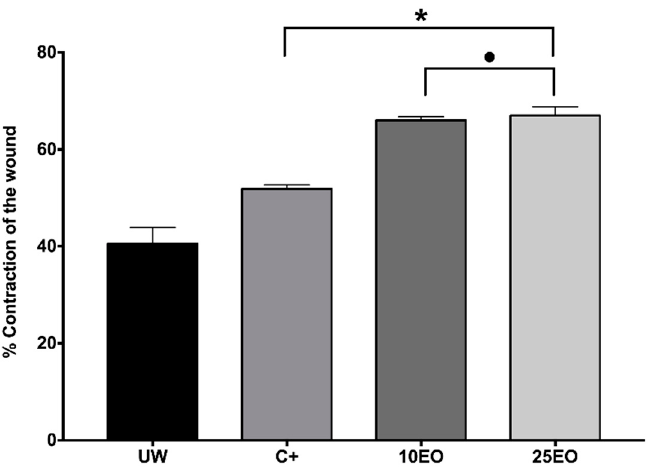
Figure 5. Percentage of wound contraction 10 days post-wound. UW, untreated wound. C + , positive control—Recoveron NC. 10EO, 10% essential oil. 25EO, 25% essential oil. * Significant differences